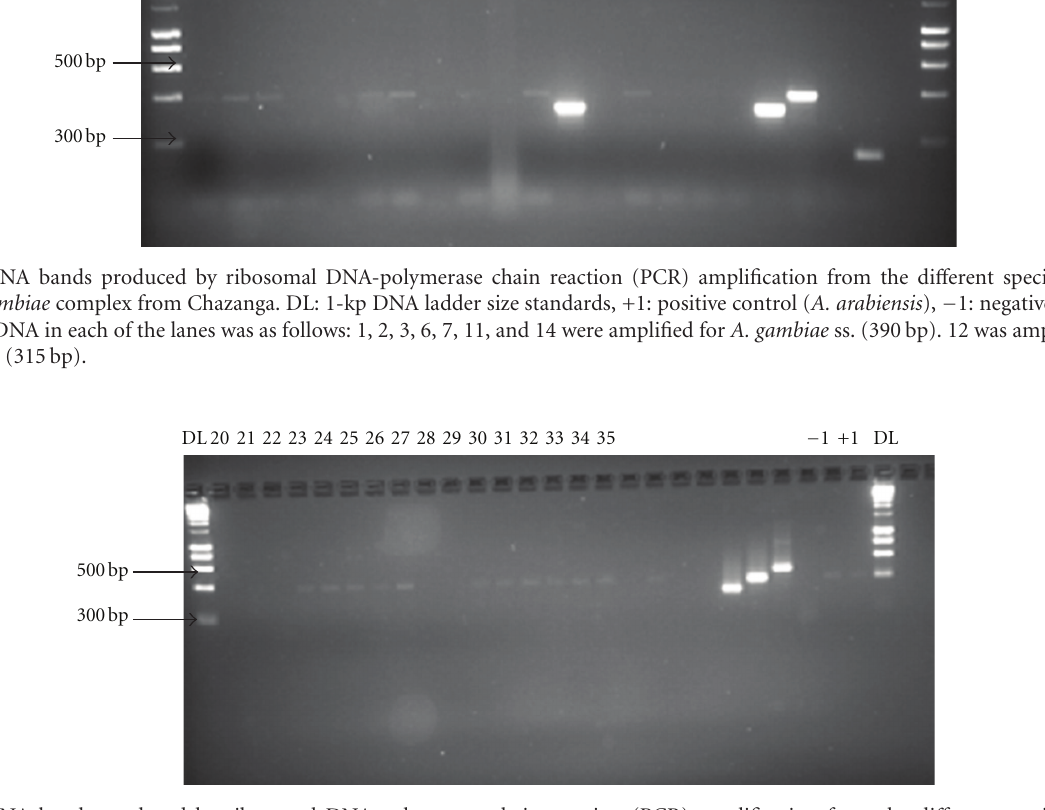
Figure 4: DNA bands produced by ribosomal DNA-polymerase chain reaction (PCR) amplification from the di ff erent species in the Anopheles gambiae complex from Kalikiliki. DL: 1-kbp DNA ladder size standards, +1: positive control ( A. arabiensis ), and − 1: negative control. The sample DNA in each of the lanes was as follows: 23, 24, 25, 26, 27, 30, 31, 32, 33, 34, and 35 were amplified for A. gambiae ss.